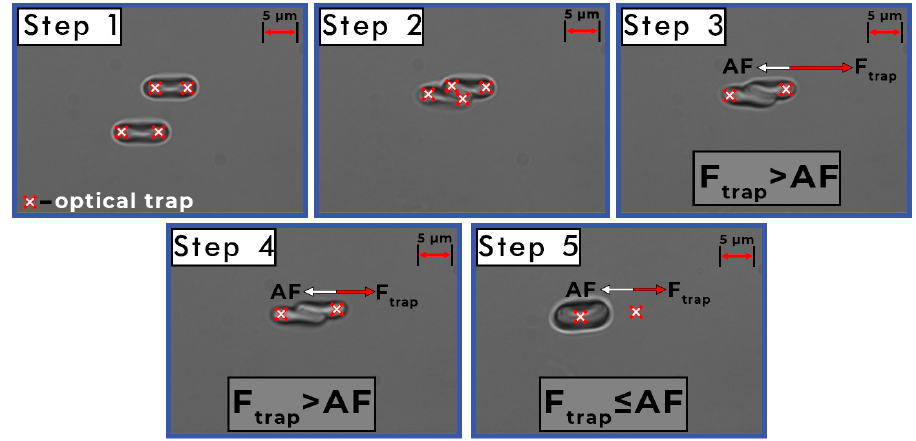
Figure 3. The step-by-step protocol of the measurement of the aggregation force (AF). Step (1): Two RBCs are trapped with four laser traps (red crosses). Step (2): RBCs are brought into contact. Step (3): the middle traps are switched off. Step (4): Process of decreasing the laser beam power (decrease in the trapping force F trap ). F trap prevents the aggregation (F trap > AF). Step (5): F trap is not enough to prevent the aggregation of RBCs (F trap ≤ AF).